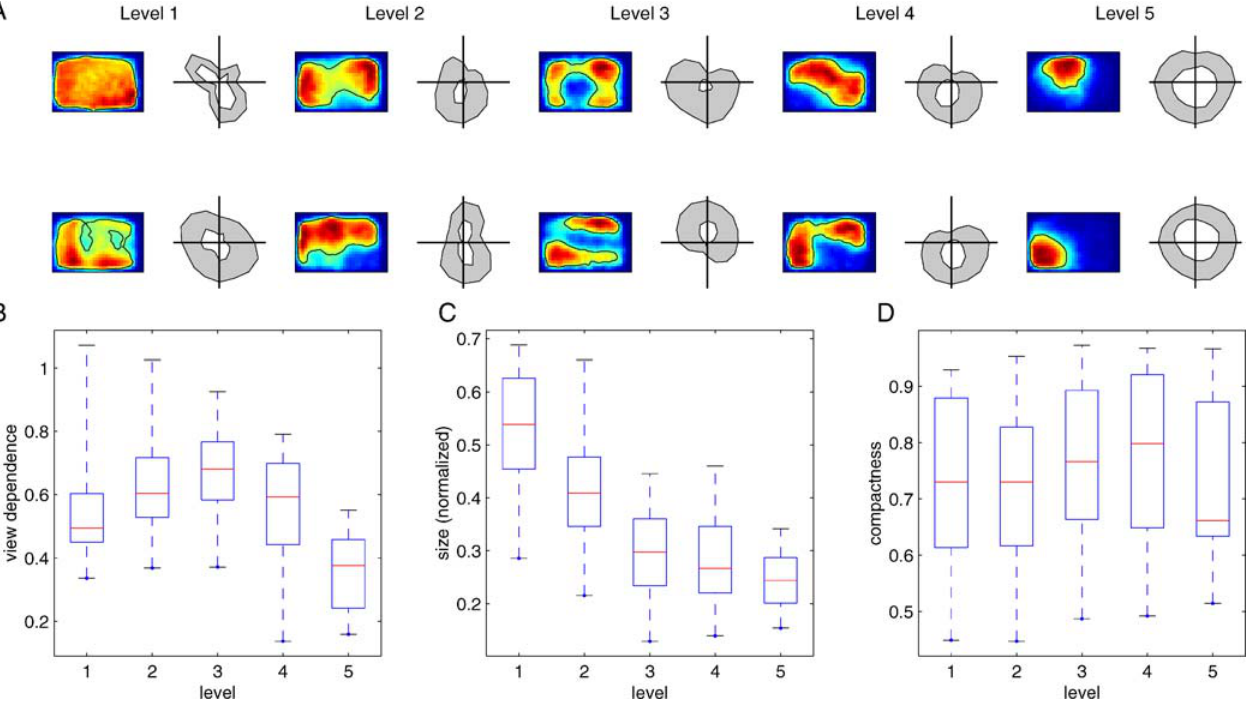
Figure 3. Response Properties of Units with Respect to Behavioral Space (A) Responses of two-example units per hierarchical level with respect to the robot’s position (left column) and its orientation (right column). The response maps show responses of cells averaged across the robot’s orientation where the black contour (responsive region) identifies the 50% level of the maximal response. The polar plot shows the mean 6 SD of the unit’s activity within the black region with respect to 16 equally spaced orientations covering 360 8 . Both response maps and polar plots are normalized to the maximal response of the units across space or orientation, respectively. (B and C) Boxplots of the view, dependence, size, and compactness of the responsive regions versus the hierarchical level of the units. The blue box represents the upper and lower quartiles. The median is indicated by the red horizontal line whereas the extent of the remaining data is given by the vertical whiskers. The view dependence is measured as the CV of the response of a unit across orientations for a fixed position, averaged across the responsive region. The size of the responsive region is normalized to the size of the environment. The compactness is given by the ratio between the true perimeter of the 50% contour and the perimeter of a disc with equal area. DOI: 10.1371/journal.pbio.0040120.g003